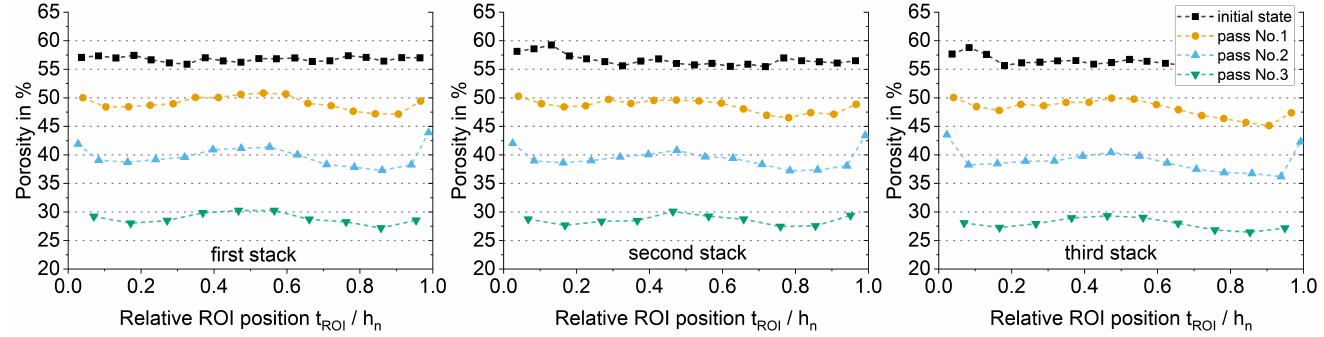
Figure 12. Series I: 20-0.50-3 ( l d / h m ≈ 1.2 − 1.4): Porosity change over relative sample depth (0=upper surface; 0.5= mid-section of sample; 1=lower surface) due to rolling for first, second and third stack.